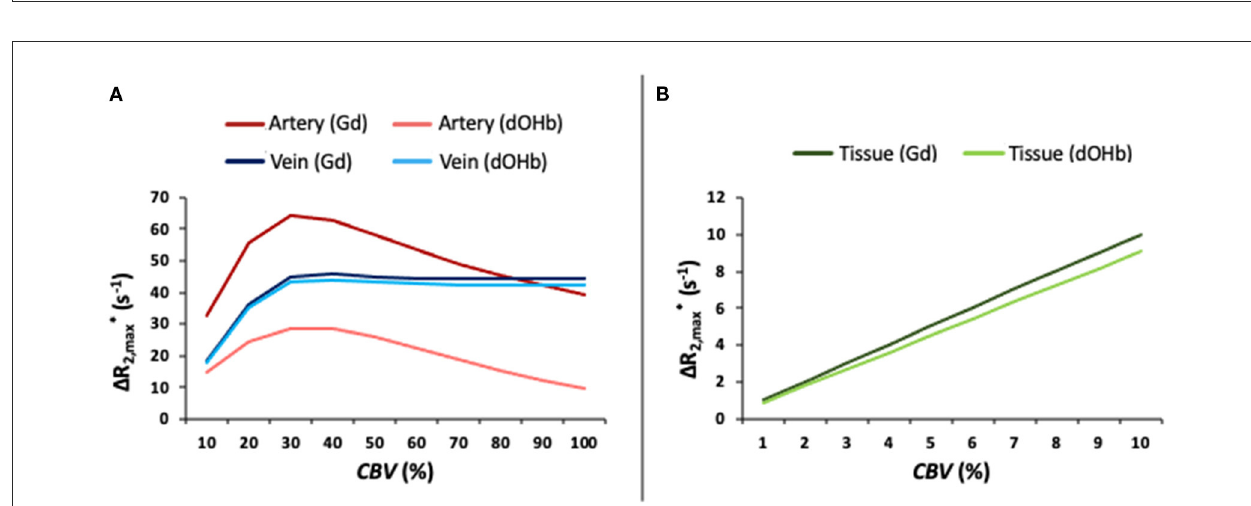
FIGURE3 1 R * 2,max as a Function of Simulated CBV (%). (A) 1 R * 2,max as a function of the simulated CBV for artery and vein in response to Gd and dOHb. (B) 1 R * 2,max as a function of the simulated CBV for tissue ( CBV WM ≈ 2%; CBV GM ≈ 4%) in response to Gd and dOHb. Note that the simulated dOHb bolus follows a 98–75% S a O 2 and Gd bolus has a peak input concentration of 2mM.